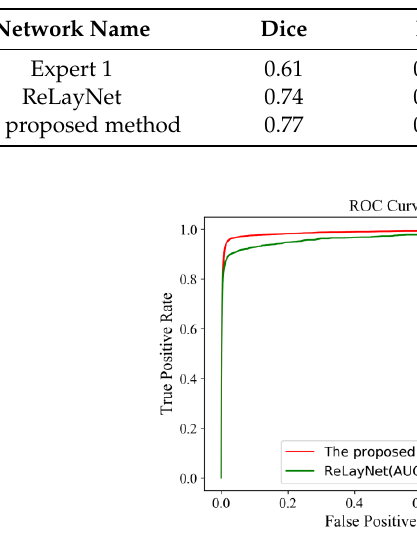
Table 8. Quantitative comparison of segmentation results for diverse edemas in multi-regions and the expert 2 annotations as the ground truth.